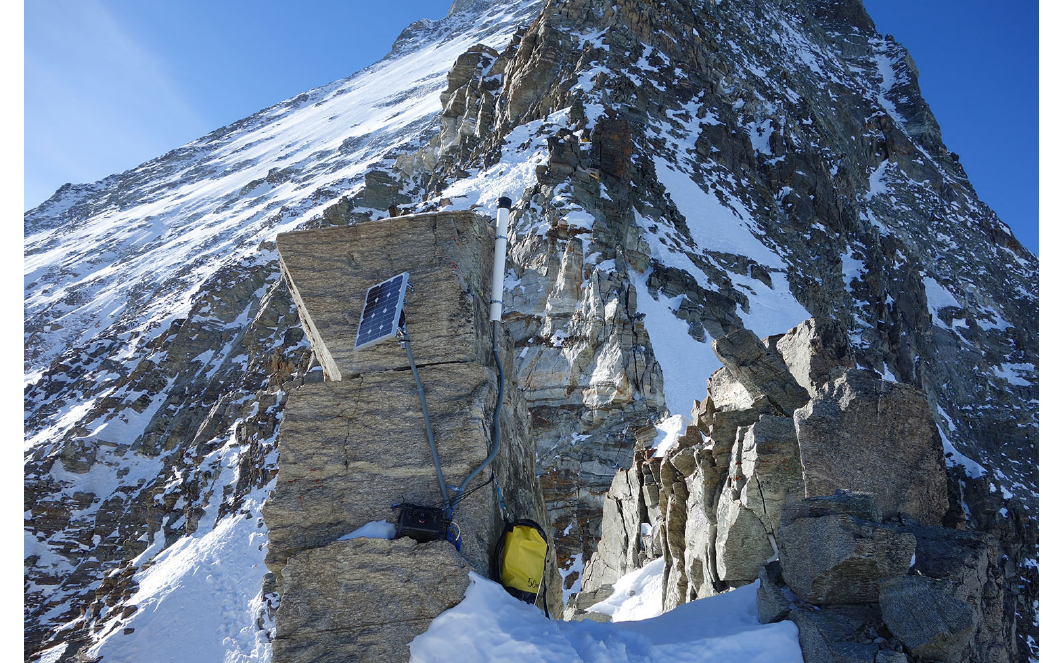
Figure C10. Wireless L1-GPS installed at position MH34 monitoring the gradual tilting of a little tower feature that is separated from the main